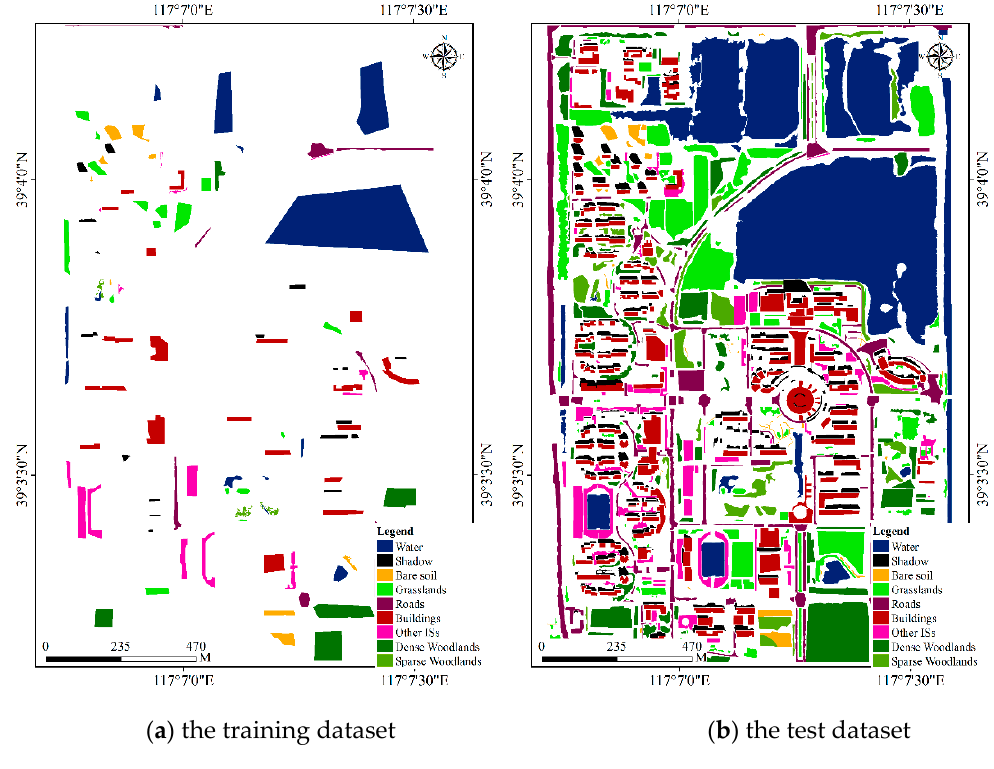
Figure 7. The training and test datasets.